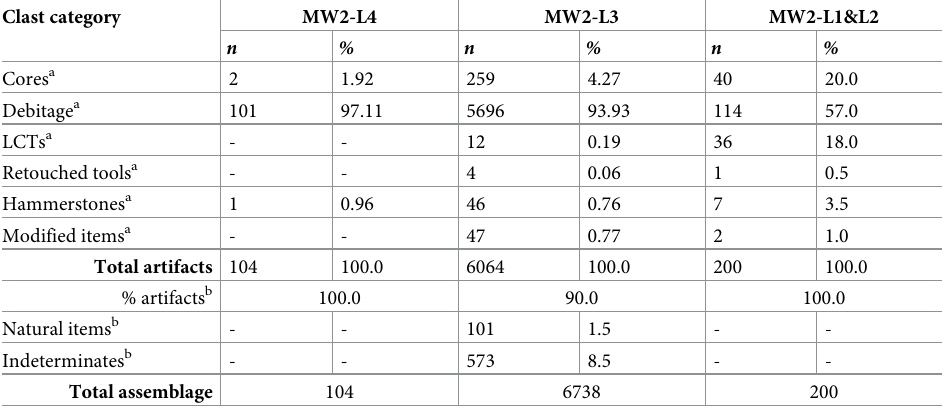
Table 1. Composition of the lithic assemblages of MW2 occupation layers.